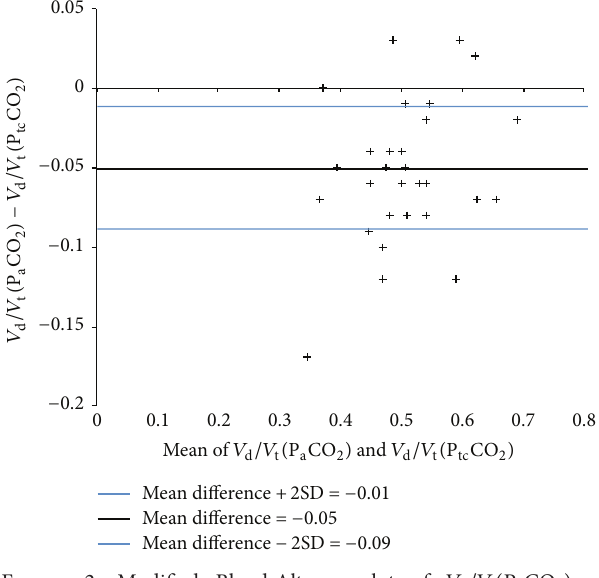
Figure 2: Modified Bland-Altman plot of 𝑉 d /𝑉 t ( P a CO 2 ) −